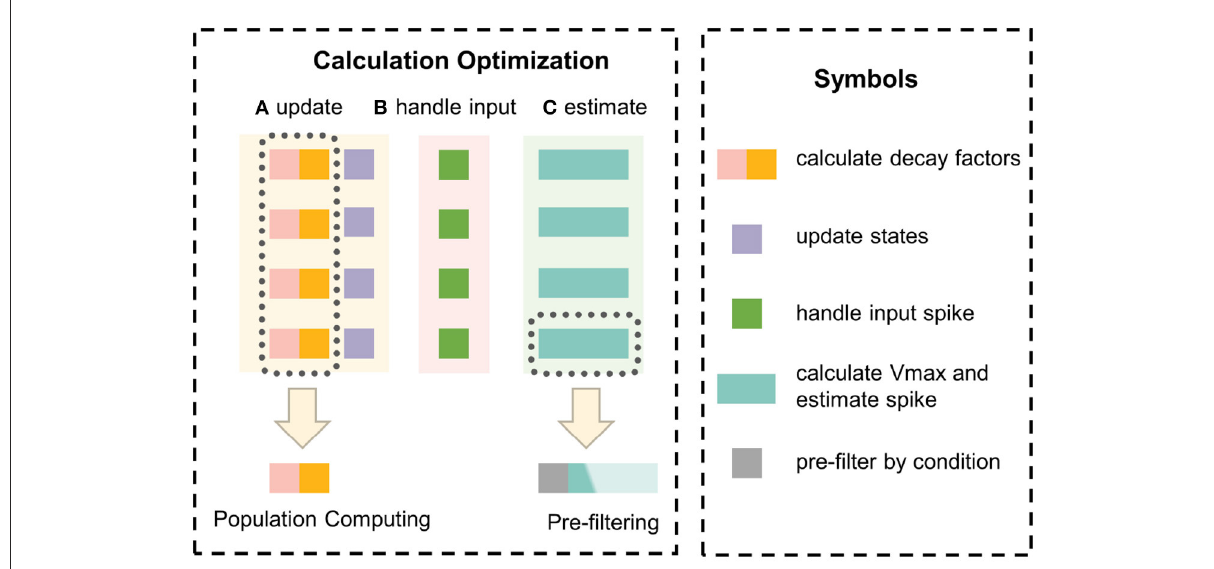
FIGURE4 The optimization principle of innovation points. Population computing uses the hidden information of the same update interval to reuse decay factors to avoid repeated calculations. Pre-filtering adopts a low-cost judgment condition to filter out unnecessary calculations to reduce the average time-consuming.